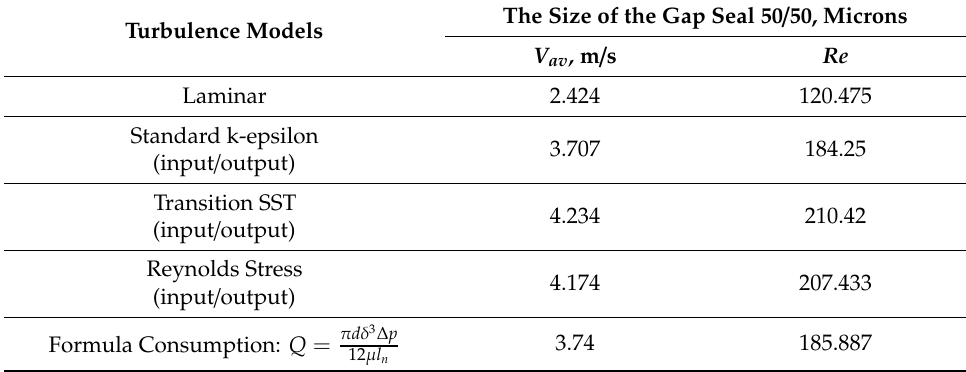
Table 1. Average fluid velocities in the gap and Reynolds numbers determined by di ff erent flow models for the laminar modes with a gap seal 50 / 50 µ